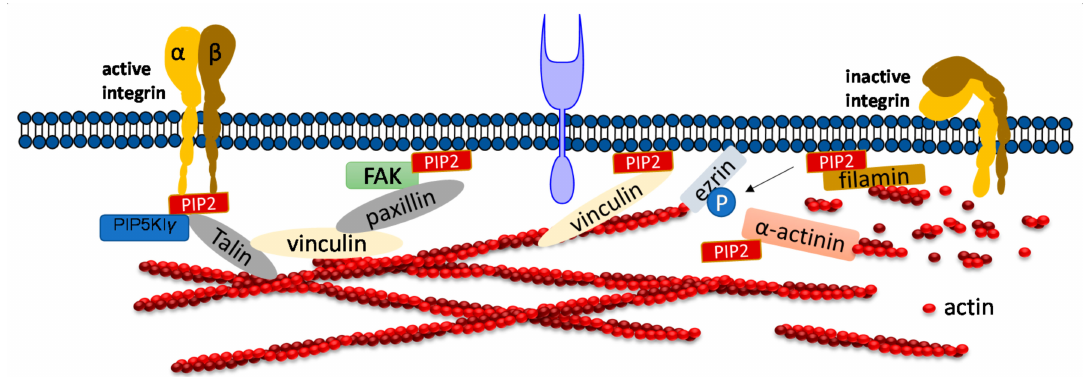
Figure 3. Role of PIP 2 in regulating focal adhesion assembly. Depiction of adhesion molecules talin, vinculin, ezrin, filamin and a-actinin. PIP 2 synergistically binds to both talin and integrin and